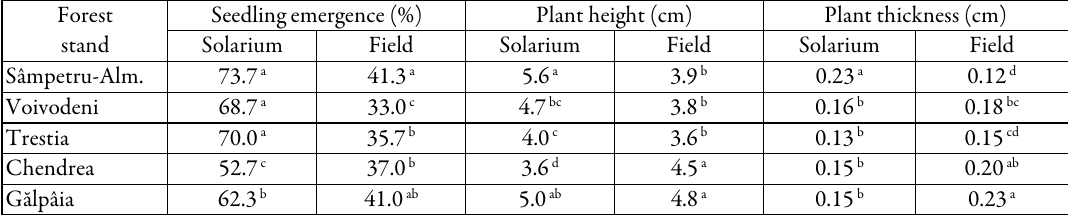
Table 5. Table 5.Table 5. Table 5. Percentage of emergence and growth of seedlings obtained from the seeds of R. pseudoacacia trees selected from the five stands, grown in solar and field